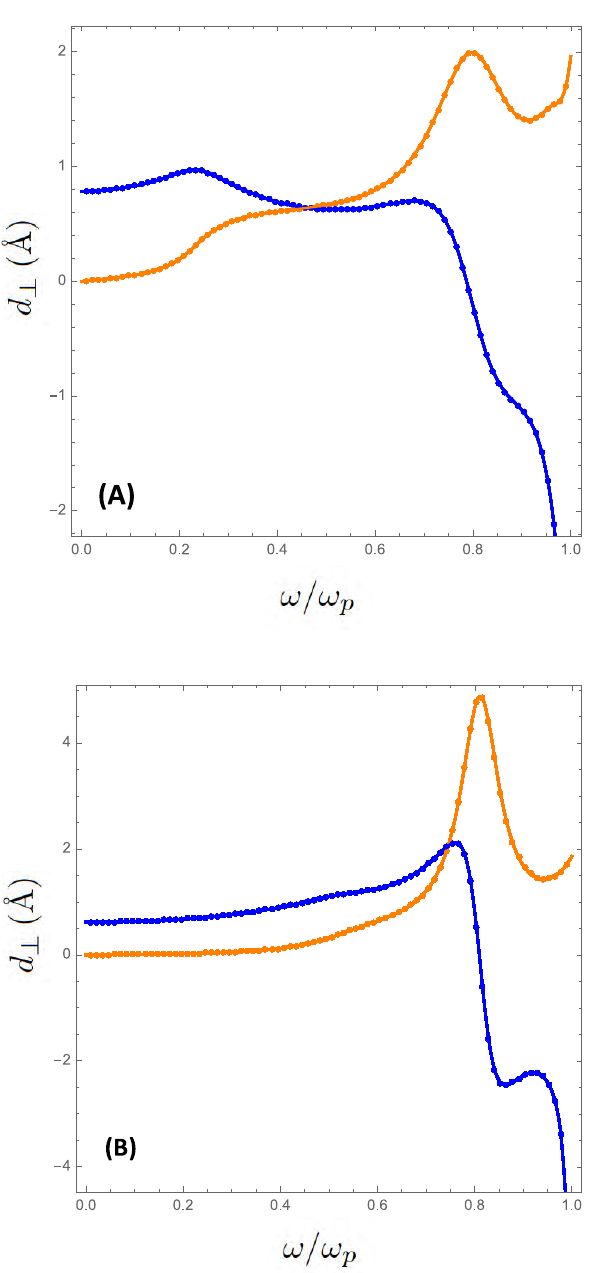
Figure 11: Spectral dependence of the frequency-dispersive effective Feibelman parameter d ⊥ for jellium metals with different Wigner–Seitz radius, where the real part (in blue) and the imaginary part (in orange) are related through Kramers–Kronig relations. (A) ∕ a = 2 typical for noble metals. (B) Jellium with Jellium with r 0 s ∕ a = 4 typical for sodium. Figure based on data from Ref. r 0 s